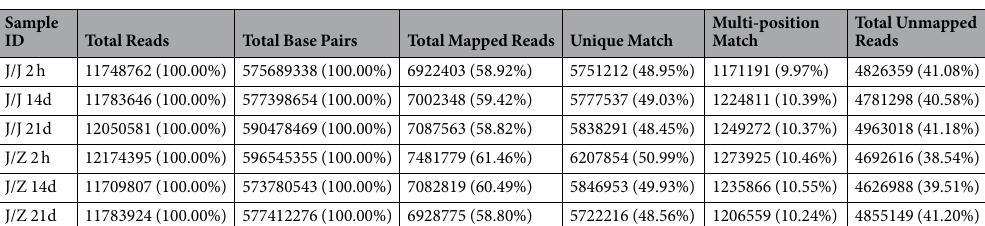
Table 1. RNA-seq reads in six RNA-seq libraries.